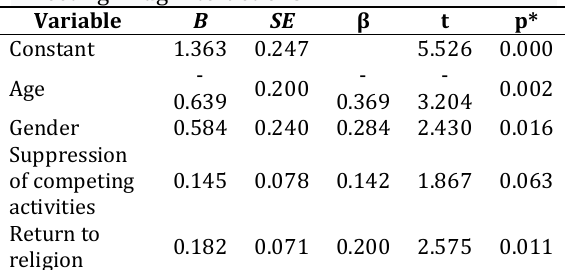
Table 5. Linear Regression Analysis of Factors Affecting Drug